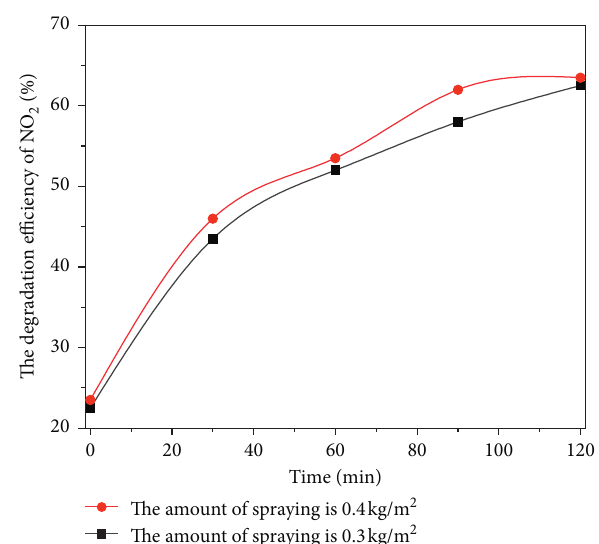
Figure 2: (a) Normal specimens. (b) Specimens covered with fog sealing.